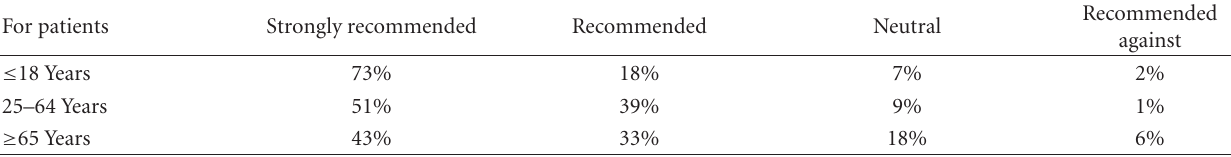
Table 2: Pulmonologists’ typical H1N1 vaccine recommendation by patient age group ( N = 945) ∗ . For patients Strongly recommended Recommended